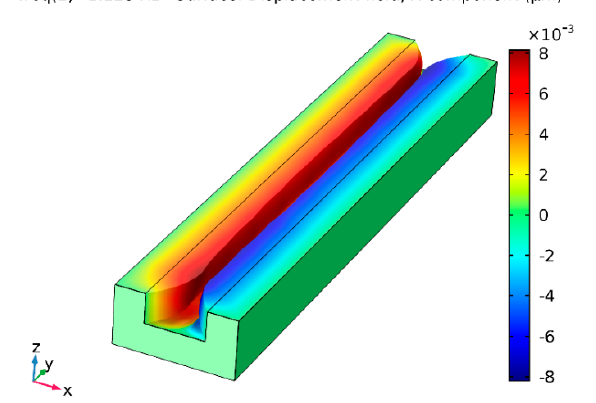
Figure 16. Surface displacement field of microchannel periodically excited at the frequency of 110 MHz: X component visualization.